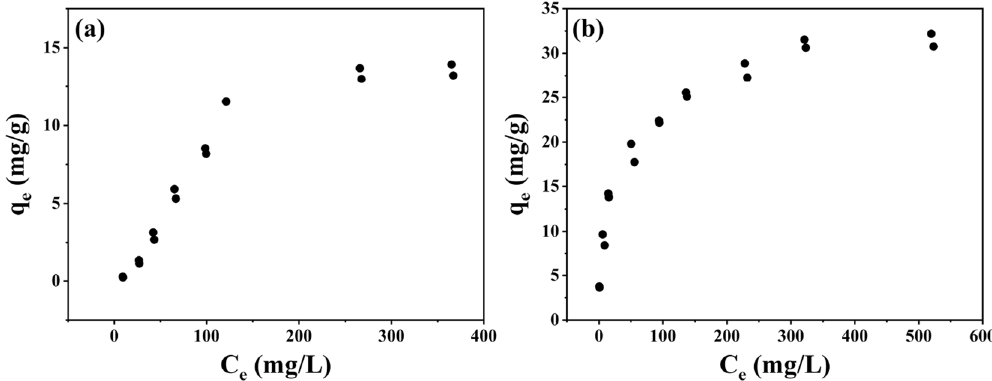
Figure 7. Adsorption isotherms of HNTs ( a ) and ChNTs ( b ). (Ce is the concentration of MO solution after the adsorption reaction reaches equilibrium, q e is the adsorption amount of MO when the adsorption reaction is equilibrium.)